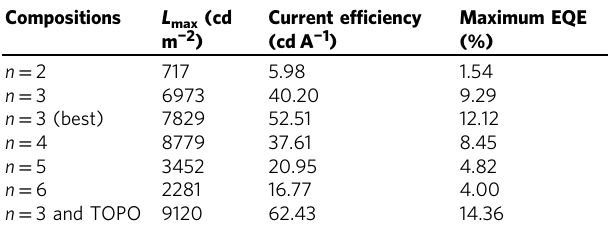
Table 1 Device performance based on quasi-two- dimensional perovskites PEA 2 (FAPbBr 3 ) n -1 PbBr 4